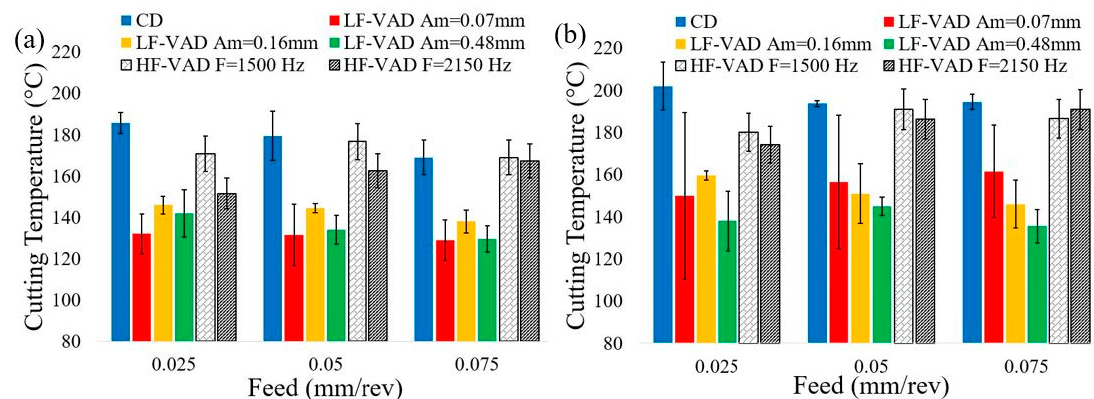
Figure 6. Effect of VAD on the cutting temperature at ( a ) N = 2000 rpm ( b ) N = 3000 rpm.